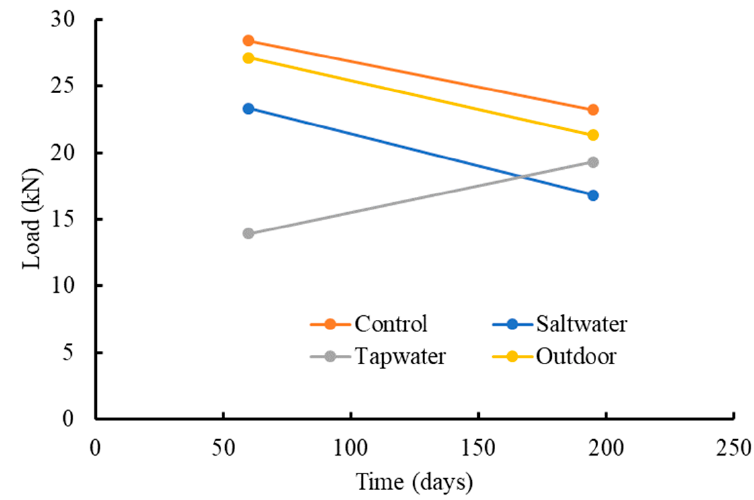
Figure 11. Effect of 195 days of exposure on CFRP strength.